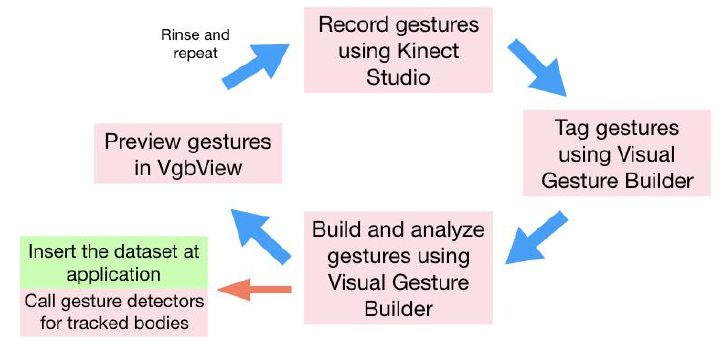
Figure 1. Overview of the build process used to create a dataset [43].